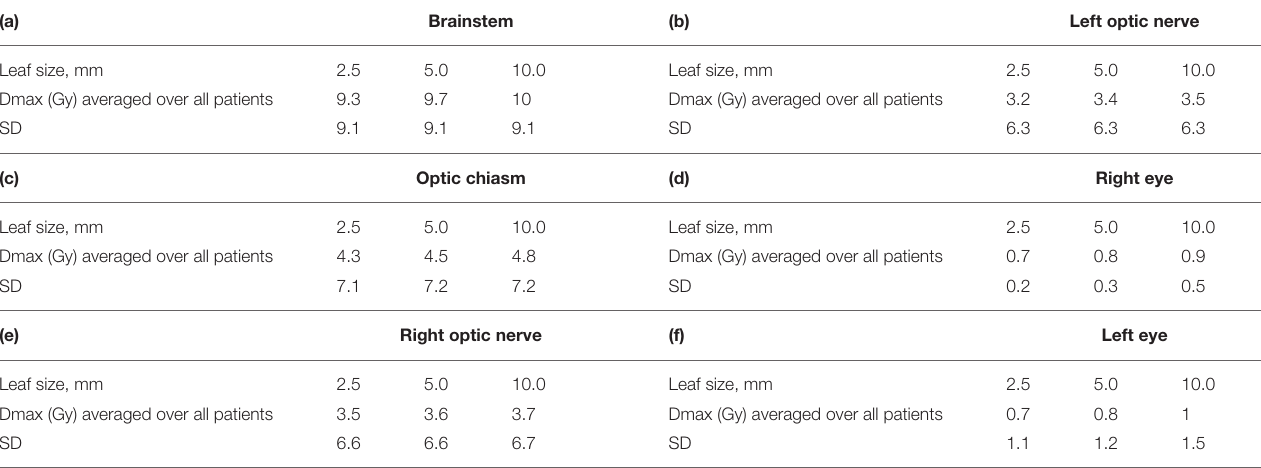
TABLE 3 | Maximum dose to organs at risk for a prescription dose of 20Gy. (a)